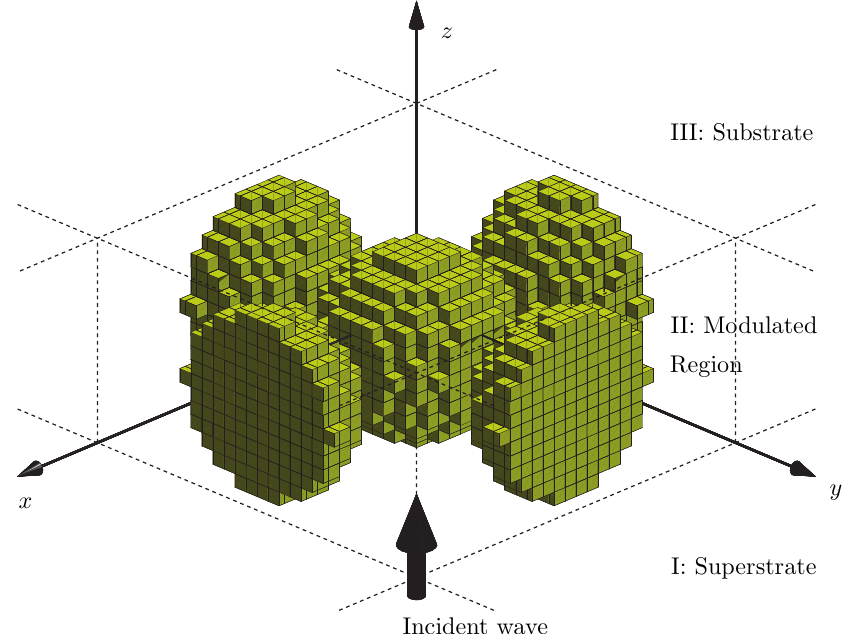
Figure 1. An illustration of the rigorous numerical modeling of nanostructures, where the 3D space is divided into (I) superstrate, (II) modulated region and (III) substrate. The permittivity- modulated structure in region II is quantized in cuboid blocks, each with a constant value of the dielectric